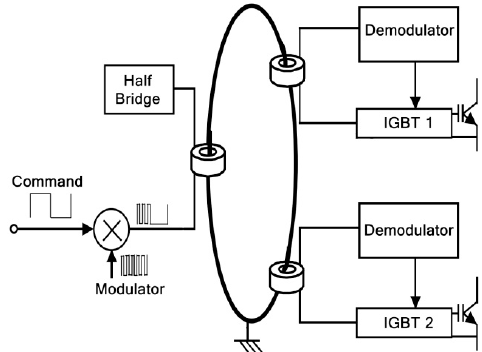
Figure 4. Double galvanic insulated firing circuit.